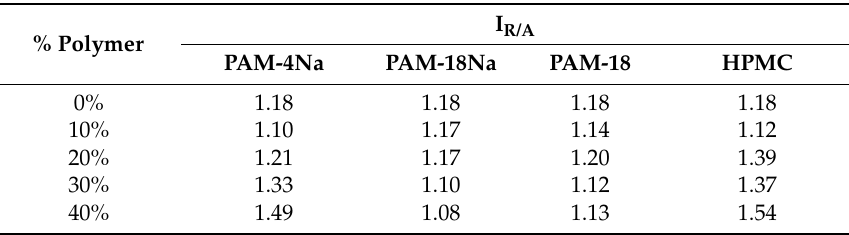
Figure 4. Surfaces of ampicillin trihydrate tablets at different ratios of polymer. The green color indicates a rough surface, while red indicates a smooth surface. Table 2. Roughness index (I R/A ) of ampicillin trihydrate tablets at different polymer proportions.